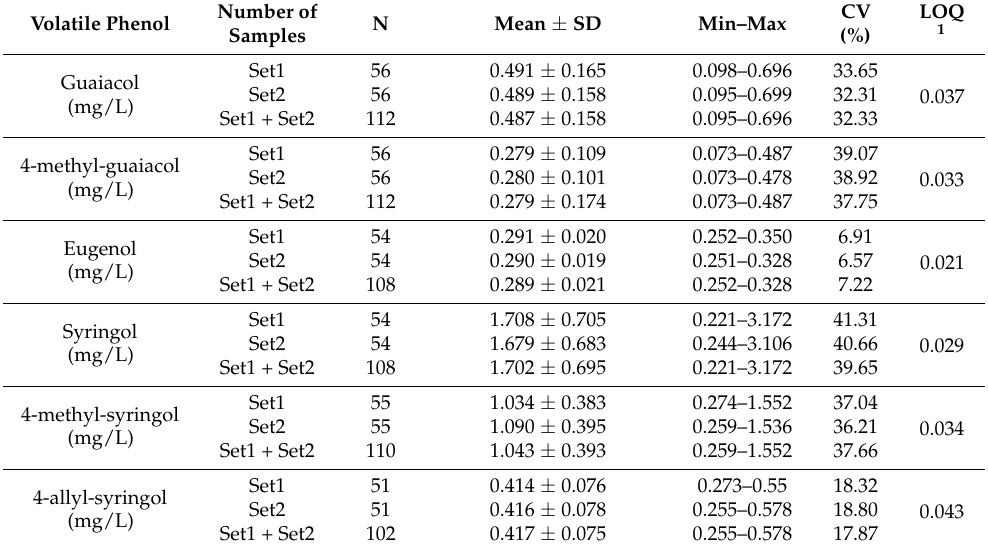
Table 2. Statistics of the sample sets for guaiacol, 4-methyl guaiacol, eugenol, syringol, 4-methyl- siringol and 4-allyl-syringol quantification in AWS